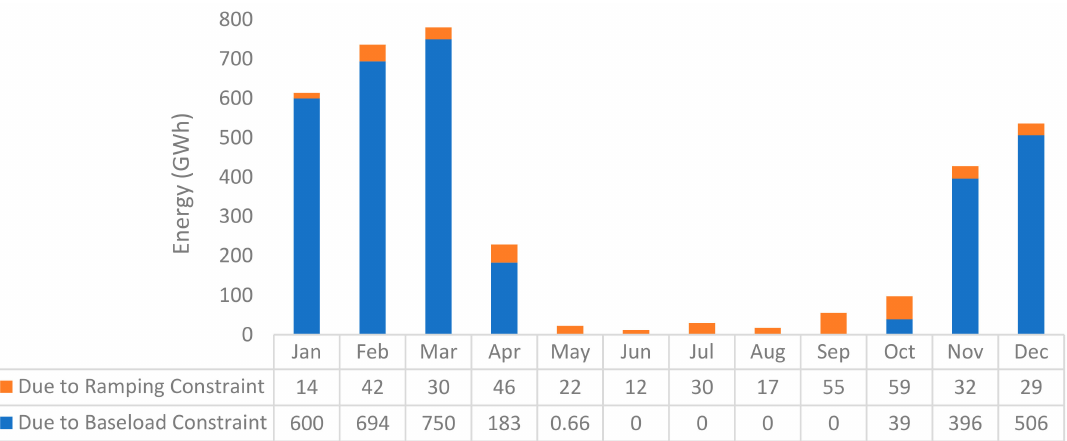
Figure 19. Sum of the PV system’s curtailed energy in GWh for each month due to the grid’s constraints at 50% PV penetration level to the grid in Riyadh,